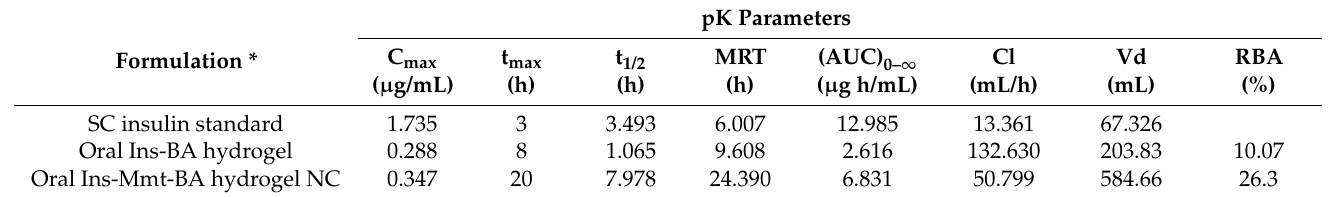
Table 7. Pharmacokinetic parameters of orally administered Ins-BA hydrogel, Ins-Mmt-BA hydrogel NC and SC standard insulin (values are significantly different * ( p <